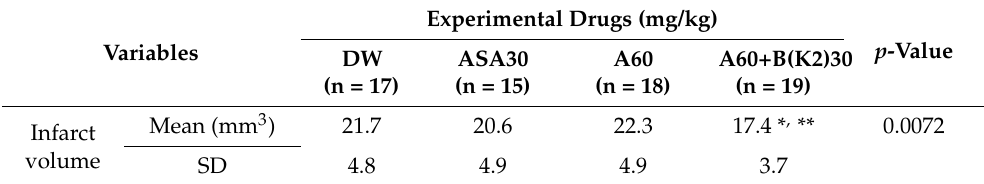
Table 6. Effects of experimental drug A60+B(K2) 30 mg/kg on infarct volume after pMCAO.